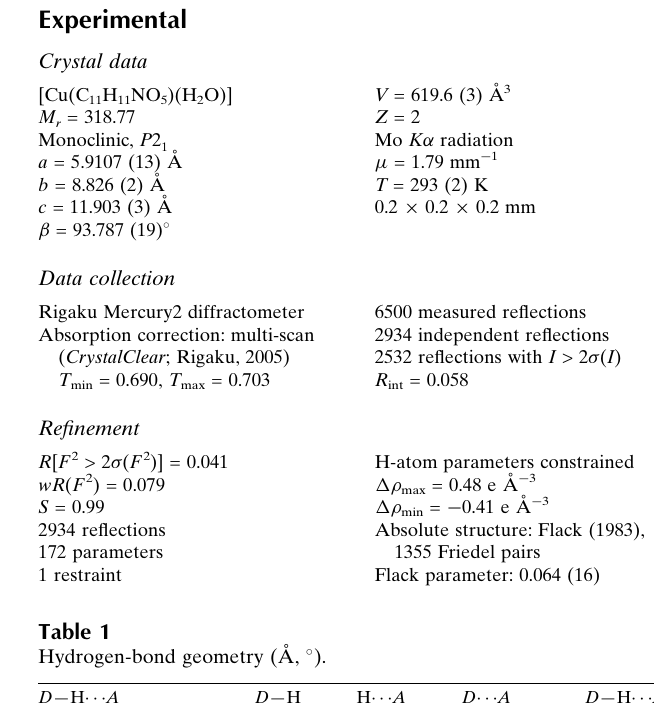
Rigaku Mercury2 diffractometer Absorption correction: multi-scan